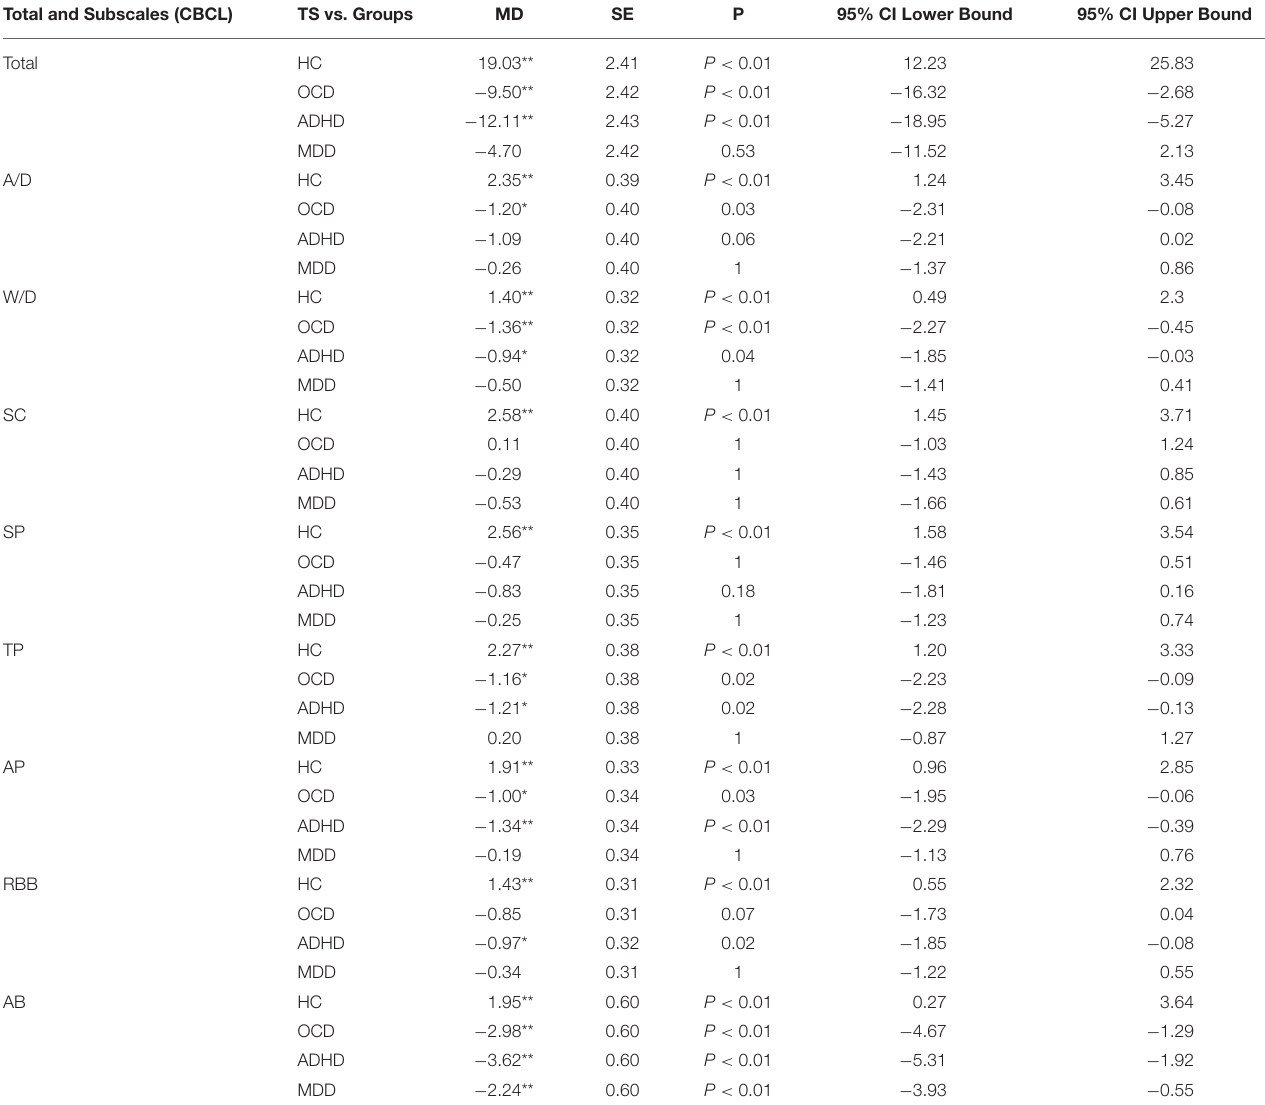
TABLE 4 | Post hoc Tests (multiple comparisons, Bonferroni correction). Total and Subscales